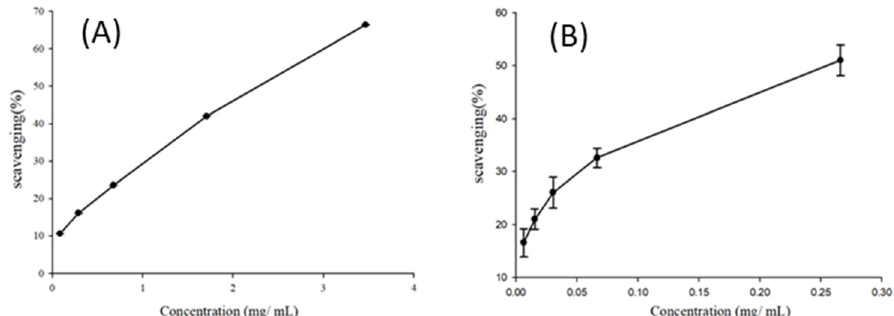
Figure 1. Comparison of EC 50 values toward 1,1-diphenyl-2-picrylhydrazyl (DPPH) assay ( A ) and 3-ethylbenzothiazolin-6-sulfonic acid (ABTS) ( B ) radical scavenging rates of lime essential oils.